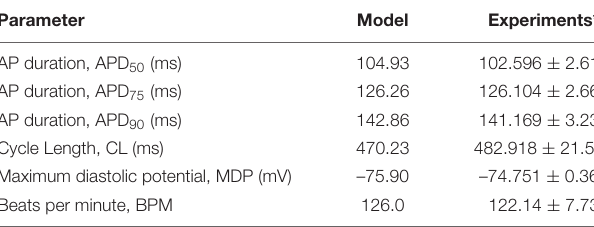
TABLE 3 | Loss and fitness values of the GA-based optimization of currents.